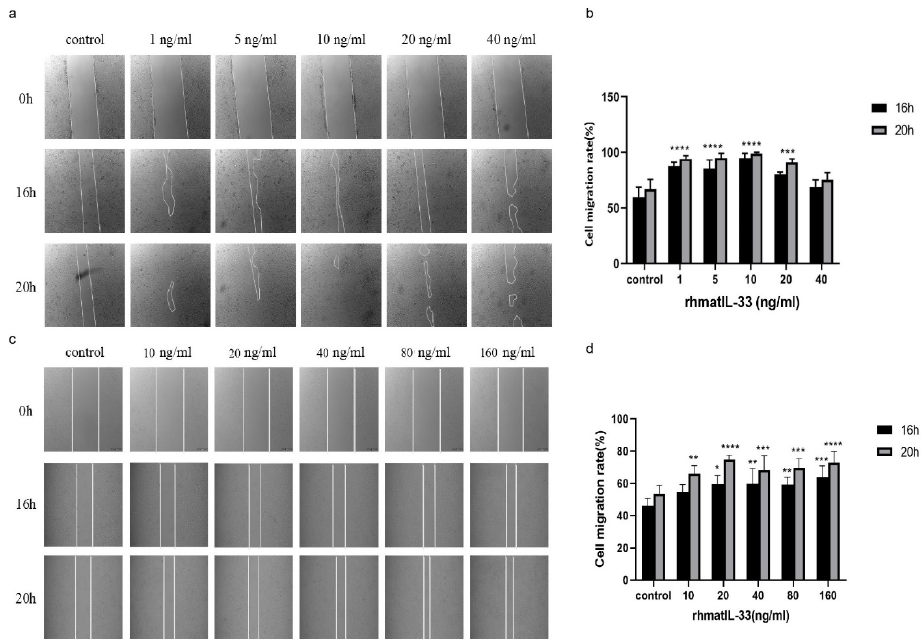
Figure 2. Effects of rhmatIL-33 on the migration of HSF and HaCaT cells. The wound-healing assay showed rhmatIL-33 accelerates the migration of ( a ) HSF and ( c ) HaCaT cells. ( a , c ) Representative images of scratched and recovered wounded areas on confluence monolayers of HSF and HaCat cells at different concentration treatments. ( b , d ) The quantitative evaluation and statistical analysis of cell migration rate in wound scratch assay measured by Image J software. The values are ex- pressed as the mean ± SEM from three independent experiments. * p , 0.05; ** p , 0.01; *** p , 0.001; **** p ,